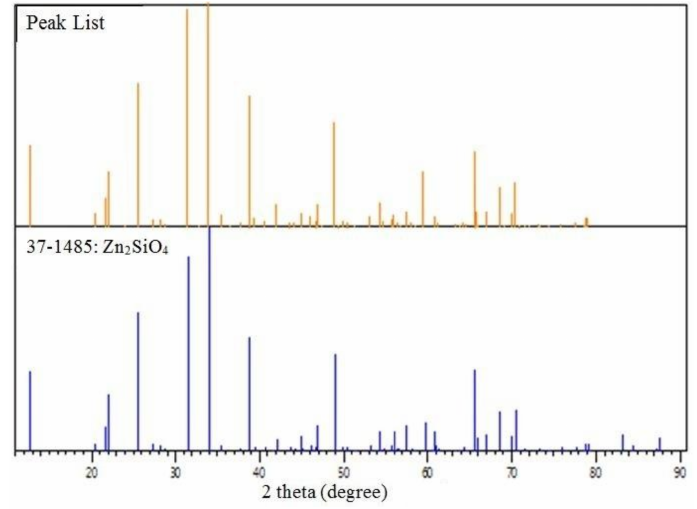
Figure 5. XRD reference patterns of willemite NPs produced at the optimum synthesis condition of 900 ◦ C for 3